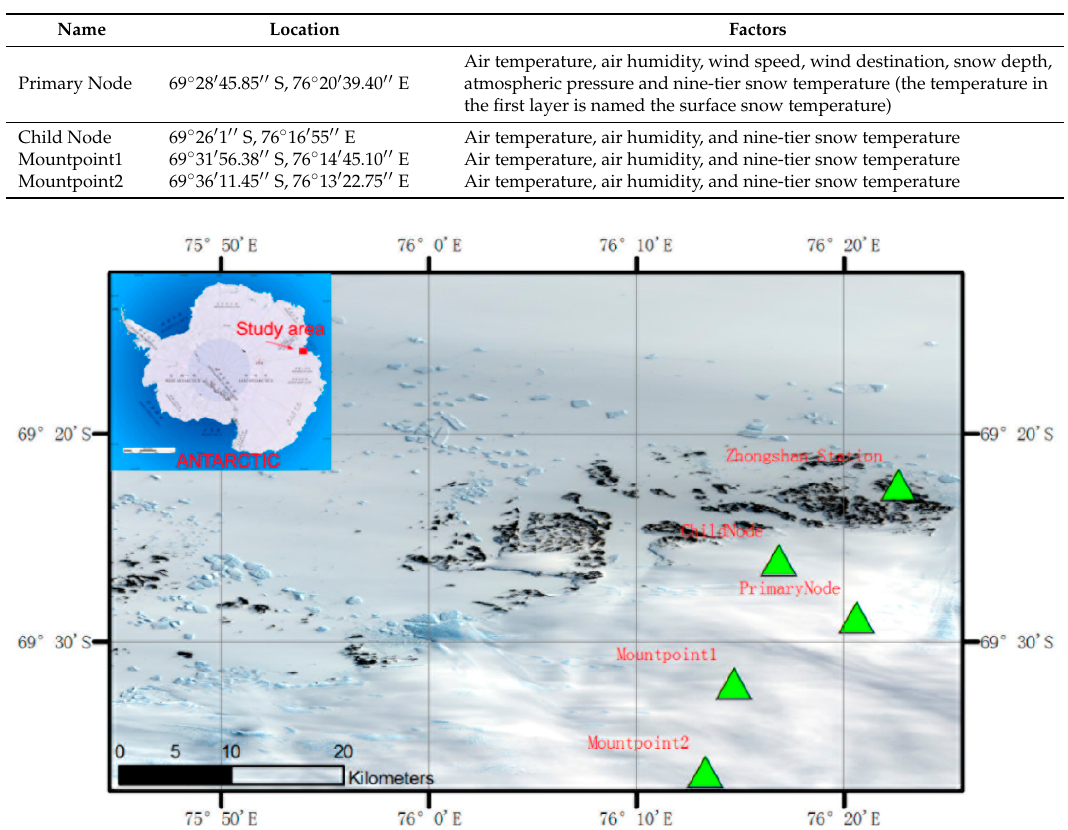
Figure 4. Field installation location of the wireless sensor network devices in Antarctica (the child node, major node, installing point 1 and 2 from the edge of the ice sheet to the left are equipped with observing devices for testing freezing and melting).